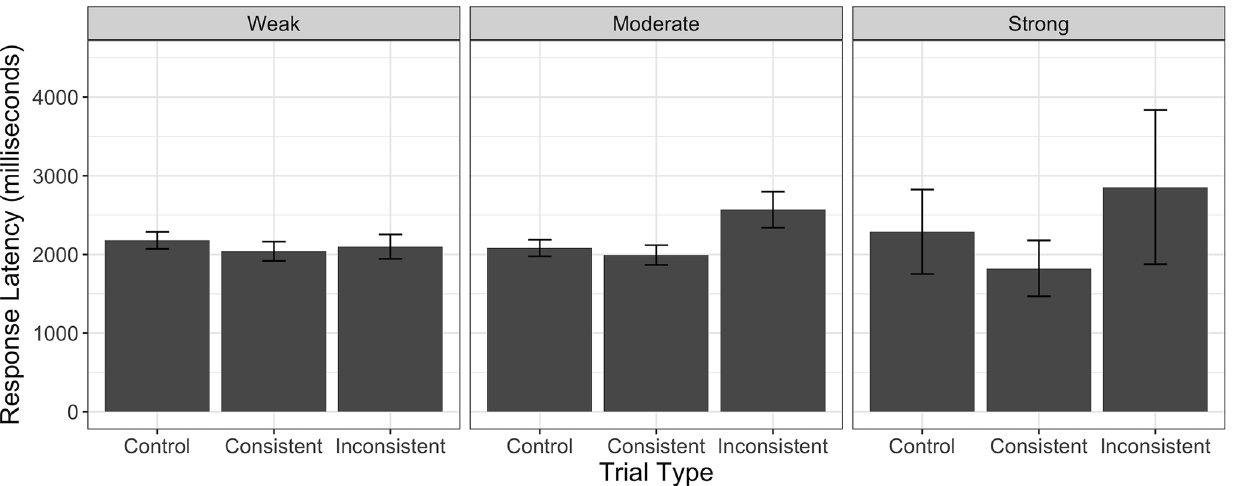
Figure 6. Effect of trial type on response latency as a function of partisan extremity (weak, moderate, strong) in Experiment 3.